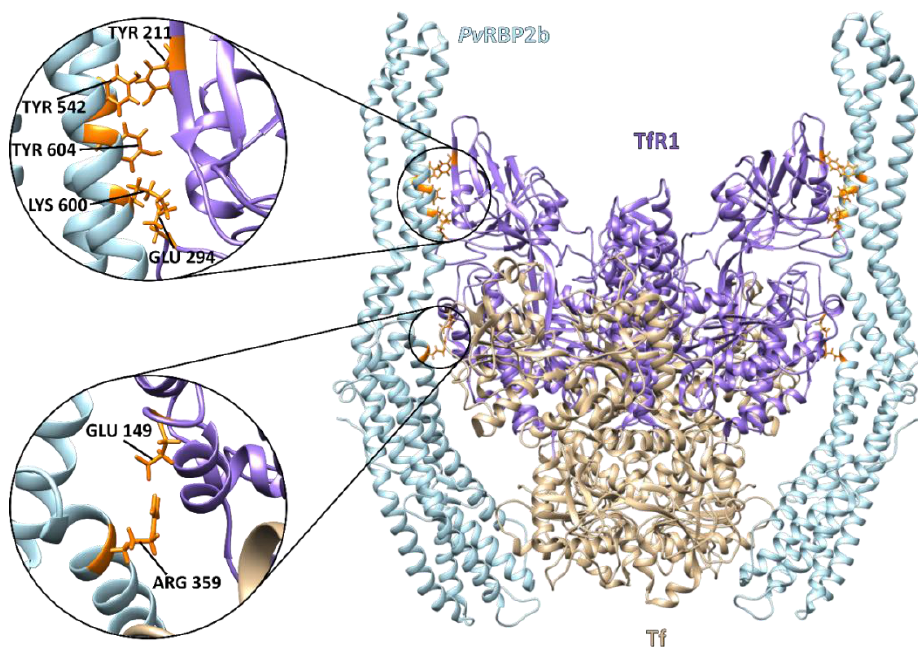
Figure 3. Cryo-electron microscopy structure of the ternary Pv RBP2b complex bound to human TfR1 and Tf (PDB: 6D04). The complex consists of homodimer TfR1 (residues 120 – 760) (purple) bound to two molecules of iron-loaded Tf (residues 1 – 679) (beige) and two molecules of Pv RBP2b (residues 168 – 633) bound on either side (light blue). The critical Pv RBP2b and TfR1 binding residues are enlarged and highlighted in orange [40].